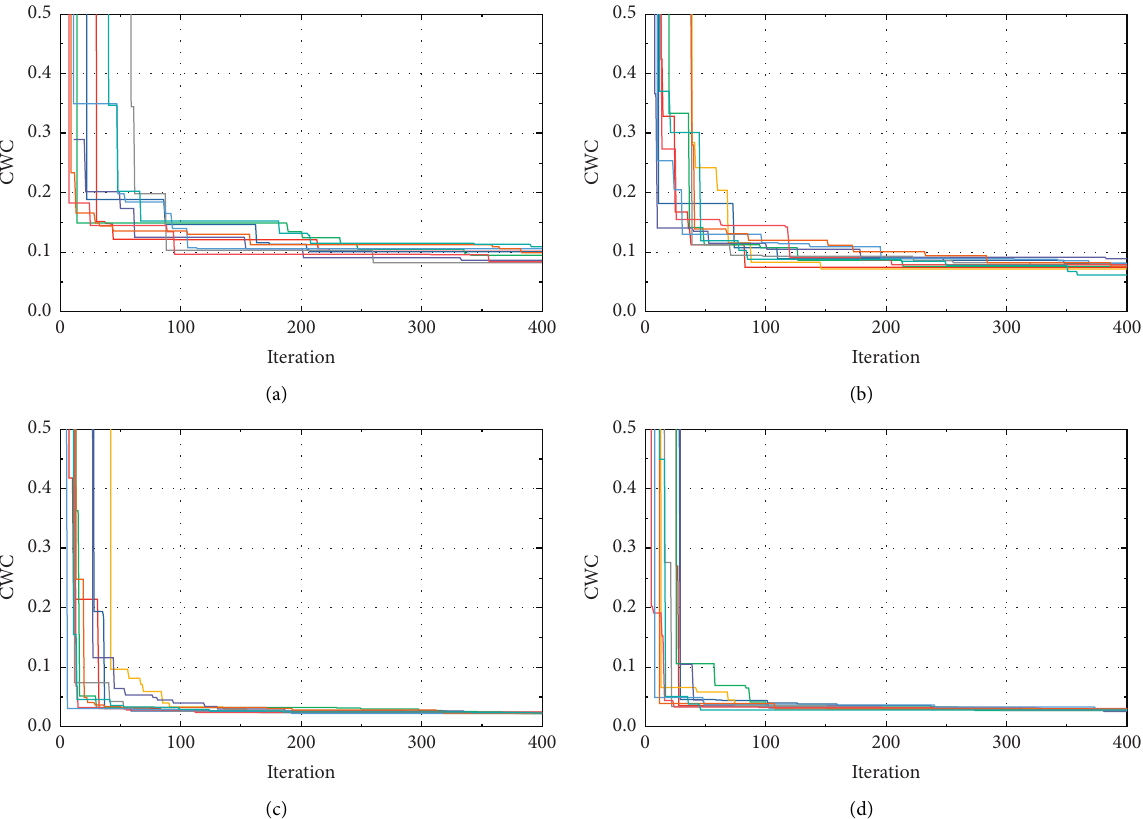
Figure 10: Convergence behaviour of the fitness function for the four monitoring points: (a) XD01 of the Baishuihe landslide; (b) ZG118 of the Baishuihe landslide; (c) ZG287 of the Tanjiahe landslide; (d) ZG289 of the Tanjiahe landslide.